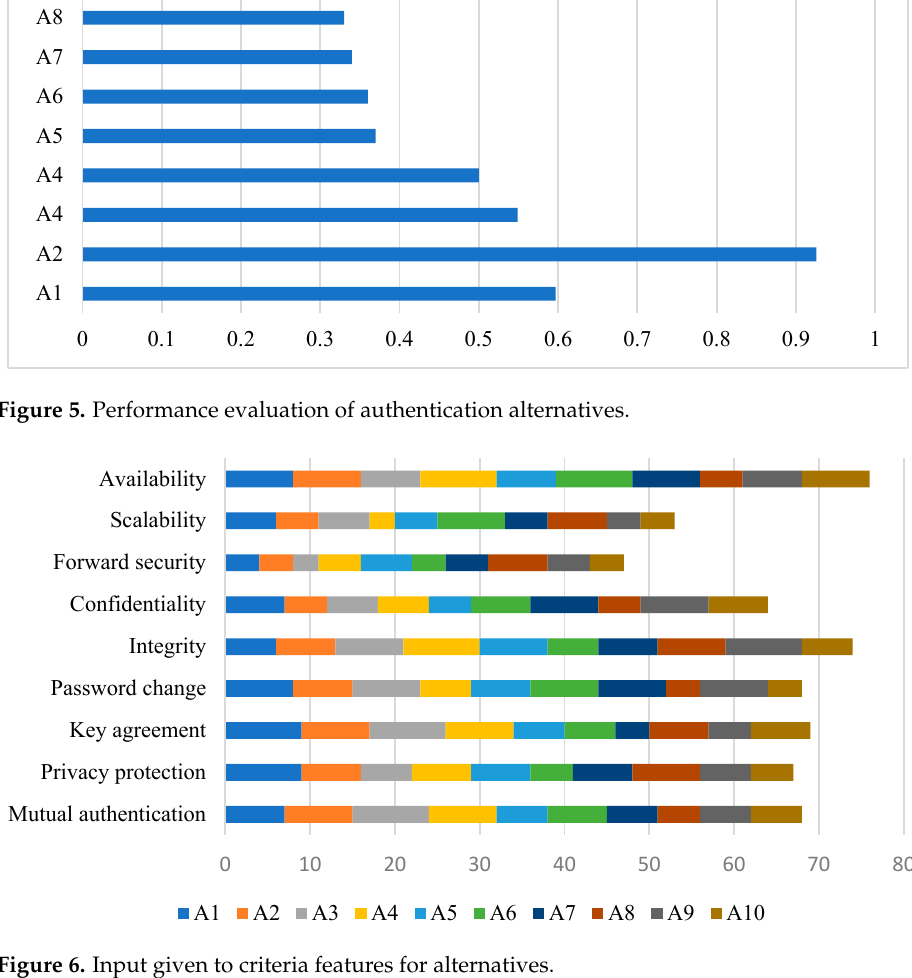
Figure 6. Input given to criteria features for alternatives.